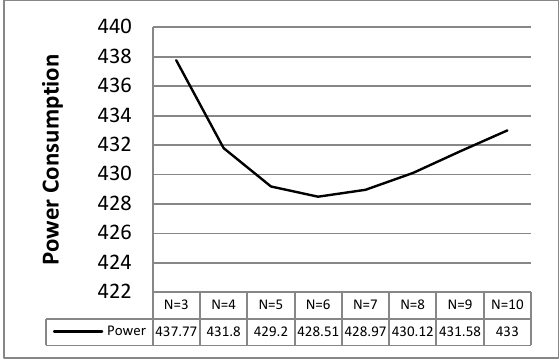
Figure 9: The threshold (N) of the lowest power